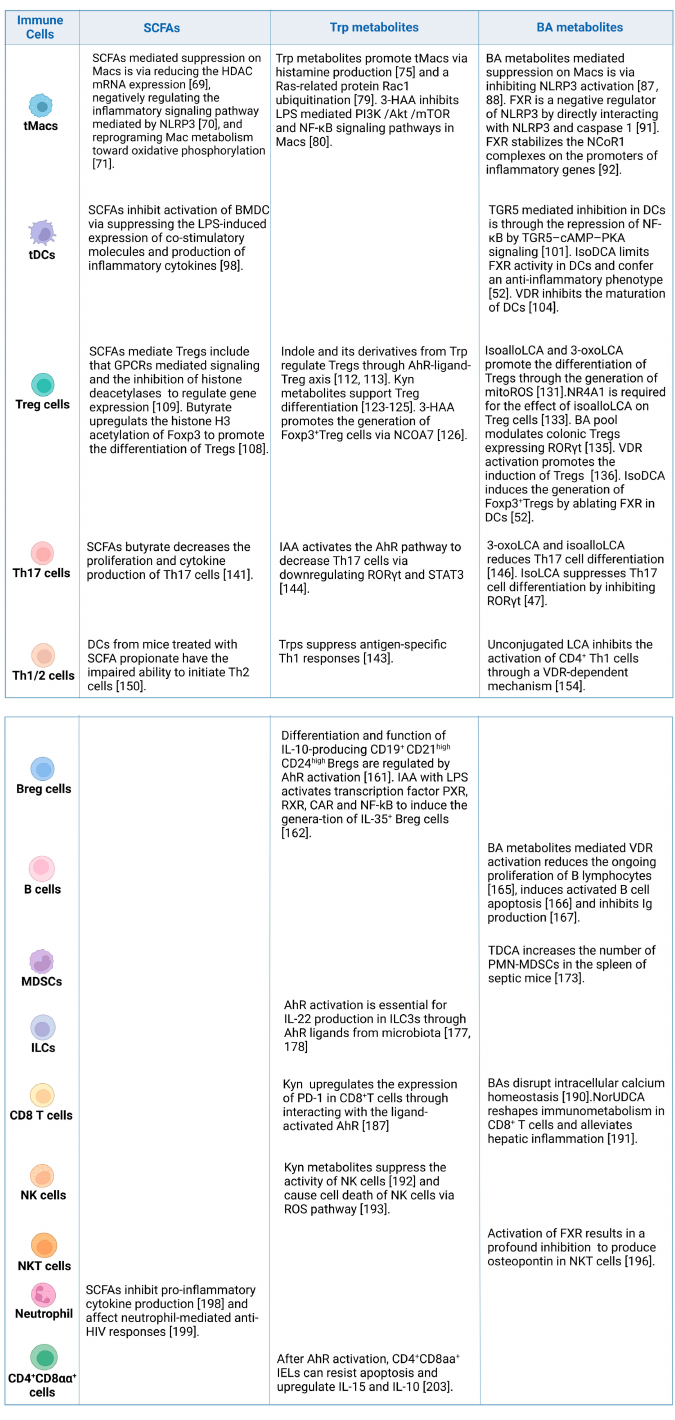
Figure 2. Regulation of gut-microbiota-derived metabolites in different immune cells. Gut-microbiota- derived metabolites such as SCFAs, Trp and BA metabolites can promote differentiation and function of immune-suppressive cells (such as tolerogenic macrophages (tMacs), tolerogenic dendritic cells (tDCs), myeloid-derived suppressor cells (MDSCs), T regulatory Foxp3 + cells (Treg), type 1 regulatory T cells (Tr1), B regulatory cells (Breg), innate lymphoid cells (ILCs) and CD4 + CD8 + αα cells), and inhibit inflammatory cells (such as CD4 + T helper (Th1), CD4 + Th2, CD4 + Th17, CD8, B cells, natural killer (NK) cells, NKT cells and